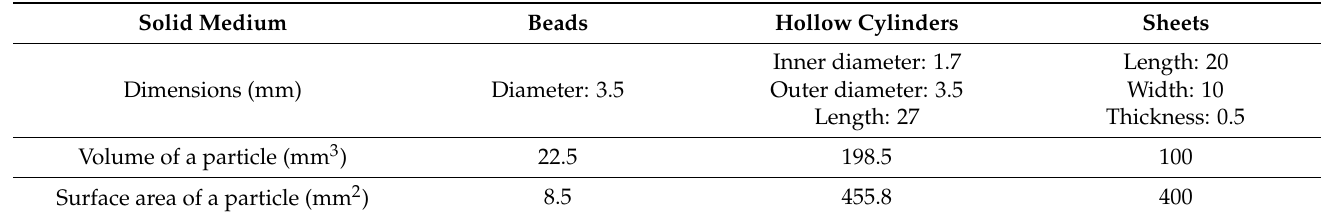
Table 1. Properties of the solid media.